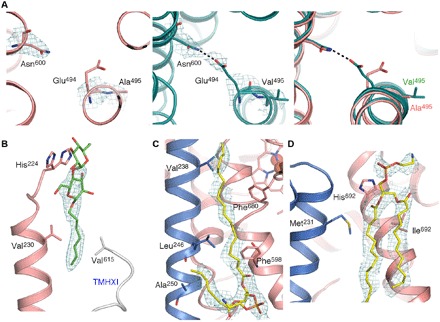
Val495Ala-BRIL structural features and lipid-protein interactions.(A) Insight into the structural impact of the Val495Ala mutation on the orientation of Glu494: left, density for Val495Ala contoured at 4σ with Glu494 side chain not visible in the density map; middle, wild-type structure density contoured at 4σ (Glu494-Asn600 salt bridge shown in black); right, aligned structures highlighting the differences between side-chain orientations (wild type in teal and Val495Ala in pink). (B) The possible truncated DDM molecule (depicted as green stick) at the dimer interface, mediated by His224, is shown in two conformations near the detergent head group, while highly conserved valine residues on TMHII (Val230 and Val237) and Pro613 from the opposing molecule (TMHXI) may stabilize the acyl chain. Symmetry-related DDM is not shown for clarity. (C) Phosphatidylethanolamine (PE) molecule, shown as a yellow stick, found toward the cytoplasmic end of the protein, with the acyl tail running close to TMHII residues (Val238, Leu246, and Ala250) of one qNOR chain (in blue) and Phe598 and Phe680 of another chain (in pink). (D) PE molecule (yellow stick) found on the periplasmic side of the dimer interface, stabilized by Met231 of TMHII, with His692 interacting electrostatically with the propionate group.